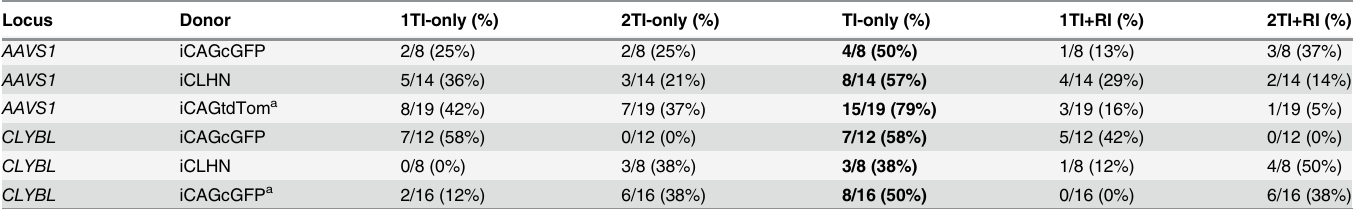
TI = targeted integration; RI = random integration. a Data from dual safe-harbor targeting